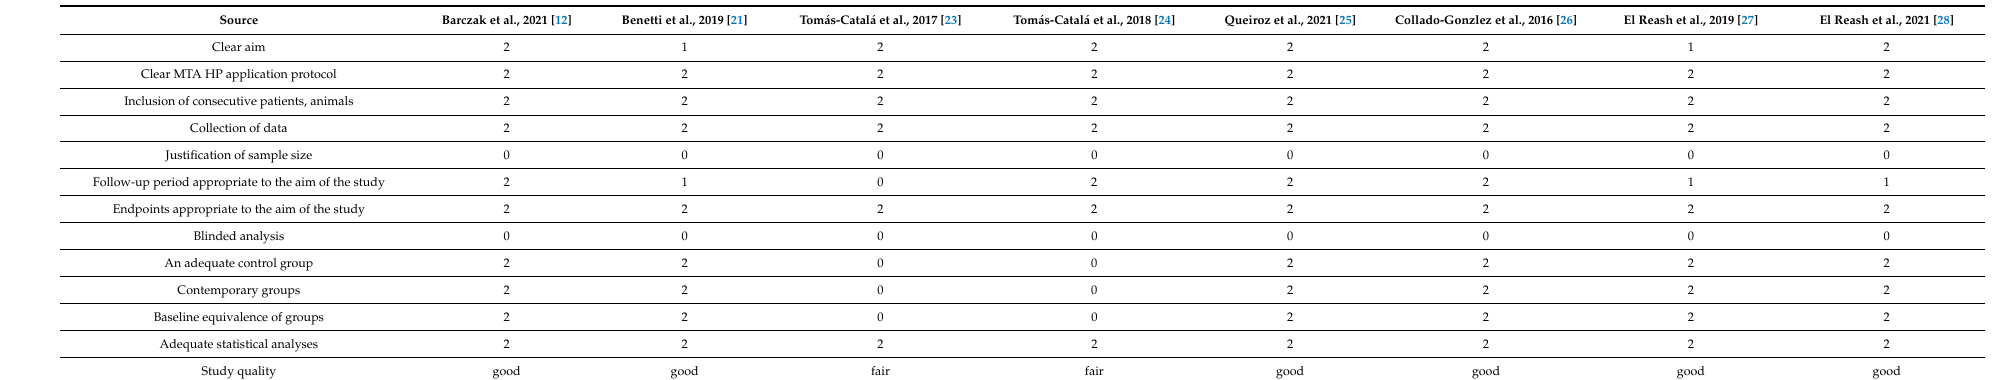
Table 5. Risk of bias according to the MINORS scale in vitro studies (modified methodological index for nonrandomized studies).